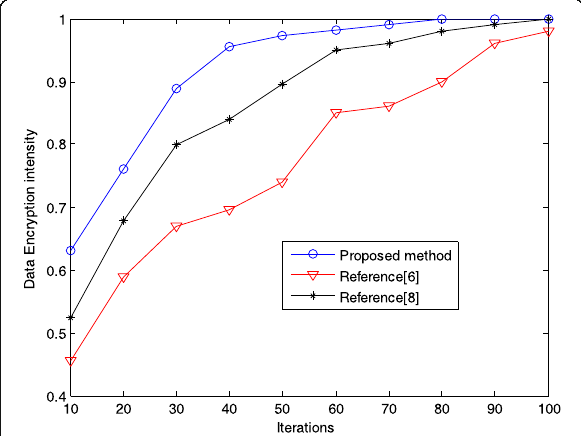
Fig. 9 The consumption power of different models is